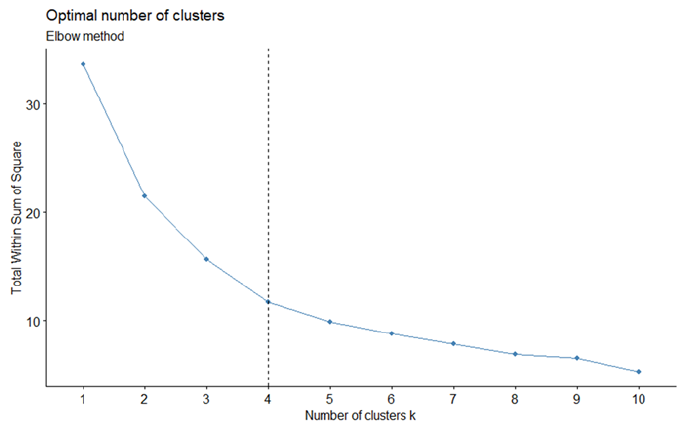
Figure 1. The Elbow